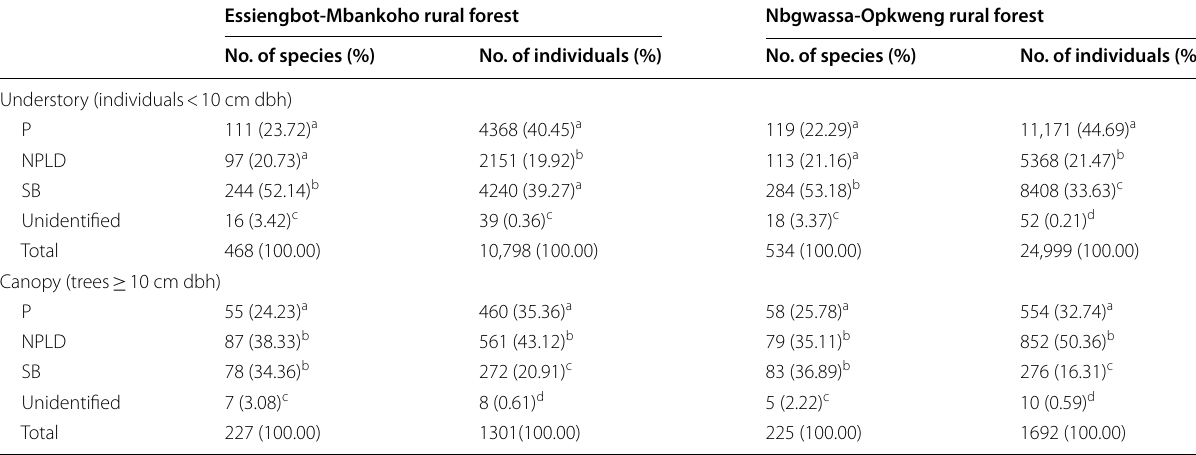
P pioneer, NPLD non-pioneer light-demanding, SB shade-bearer. Proportion (in %) of species and individuals are noted parenthetically. Values followed by different letters (a, b, c, d) within a column indicate a significant difference between the growth temperament categories in relation to light ( χ 2 -test, p <